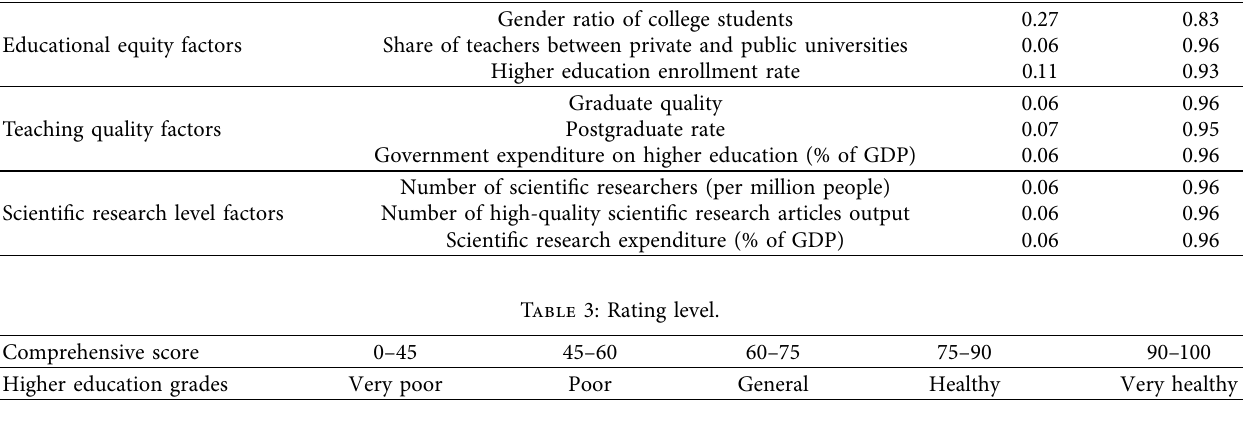
Table 4: Comprehensive score sheet.